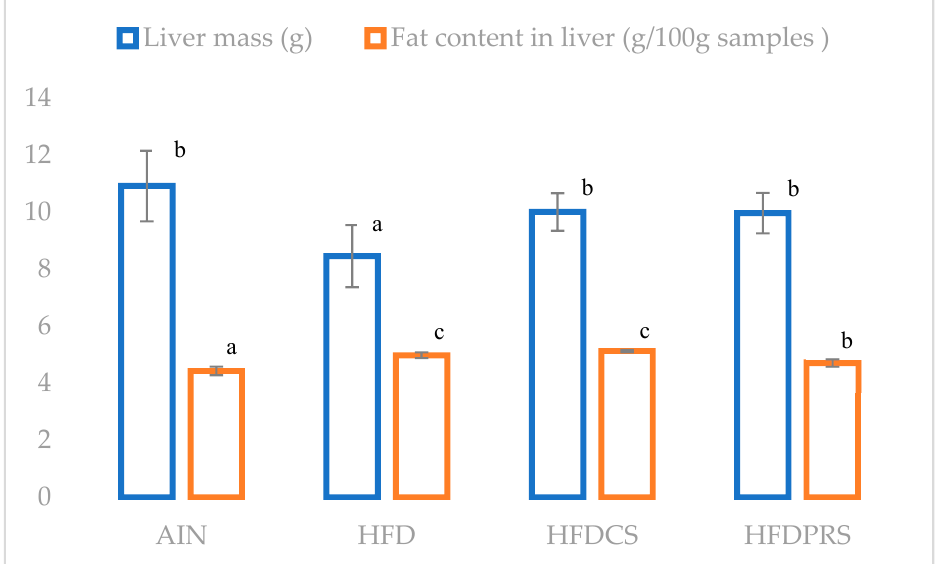
Figure 1. Total fat content and liver mass in experimental groups. Mean values with different letters above the bars differ statistically, p < 0.05. Statistical analysis was performed for liver weight and fat content separately. AIN—group fed with the basic diet AIN-93M; HFD—group fed with the basic diet AIN 93M with the addition of lard; HFDCS—group fed with the basic diet AIN-93M with the addition of lard and lyophilisate from control sprouts; HFDPRS—a group fed with the basic diet AIN-93M with the addition of lard and modified buckwheat sprouts lyophilisate. Figure 2 shows the fat content of seeds, sprouts, diets and feces of the animals. The sprouts in the control group (CS) and probiotic-rich sprouts (PRS) had a higher fat content compared to the seeds. In the case of diets, the HFD diet had the highest fat content, followed by the HFDPRS, HFDCS and AIN diets, respectively. In the case of feces, the HFDPRS-F group had the highest fat content, followed by HFCS-F, HFD-F, and AIN-F,